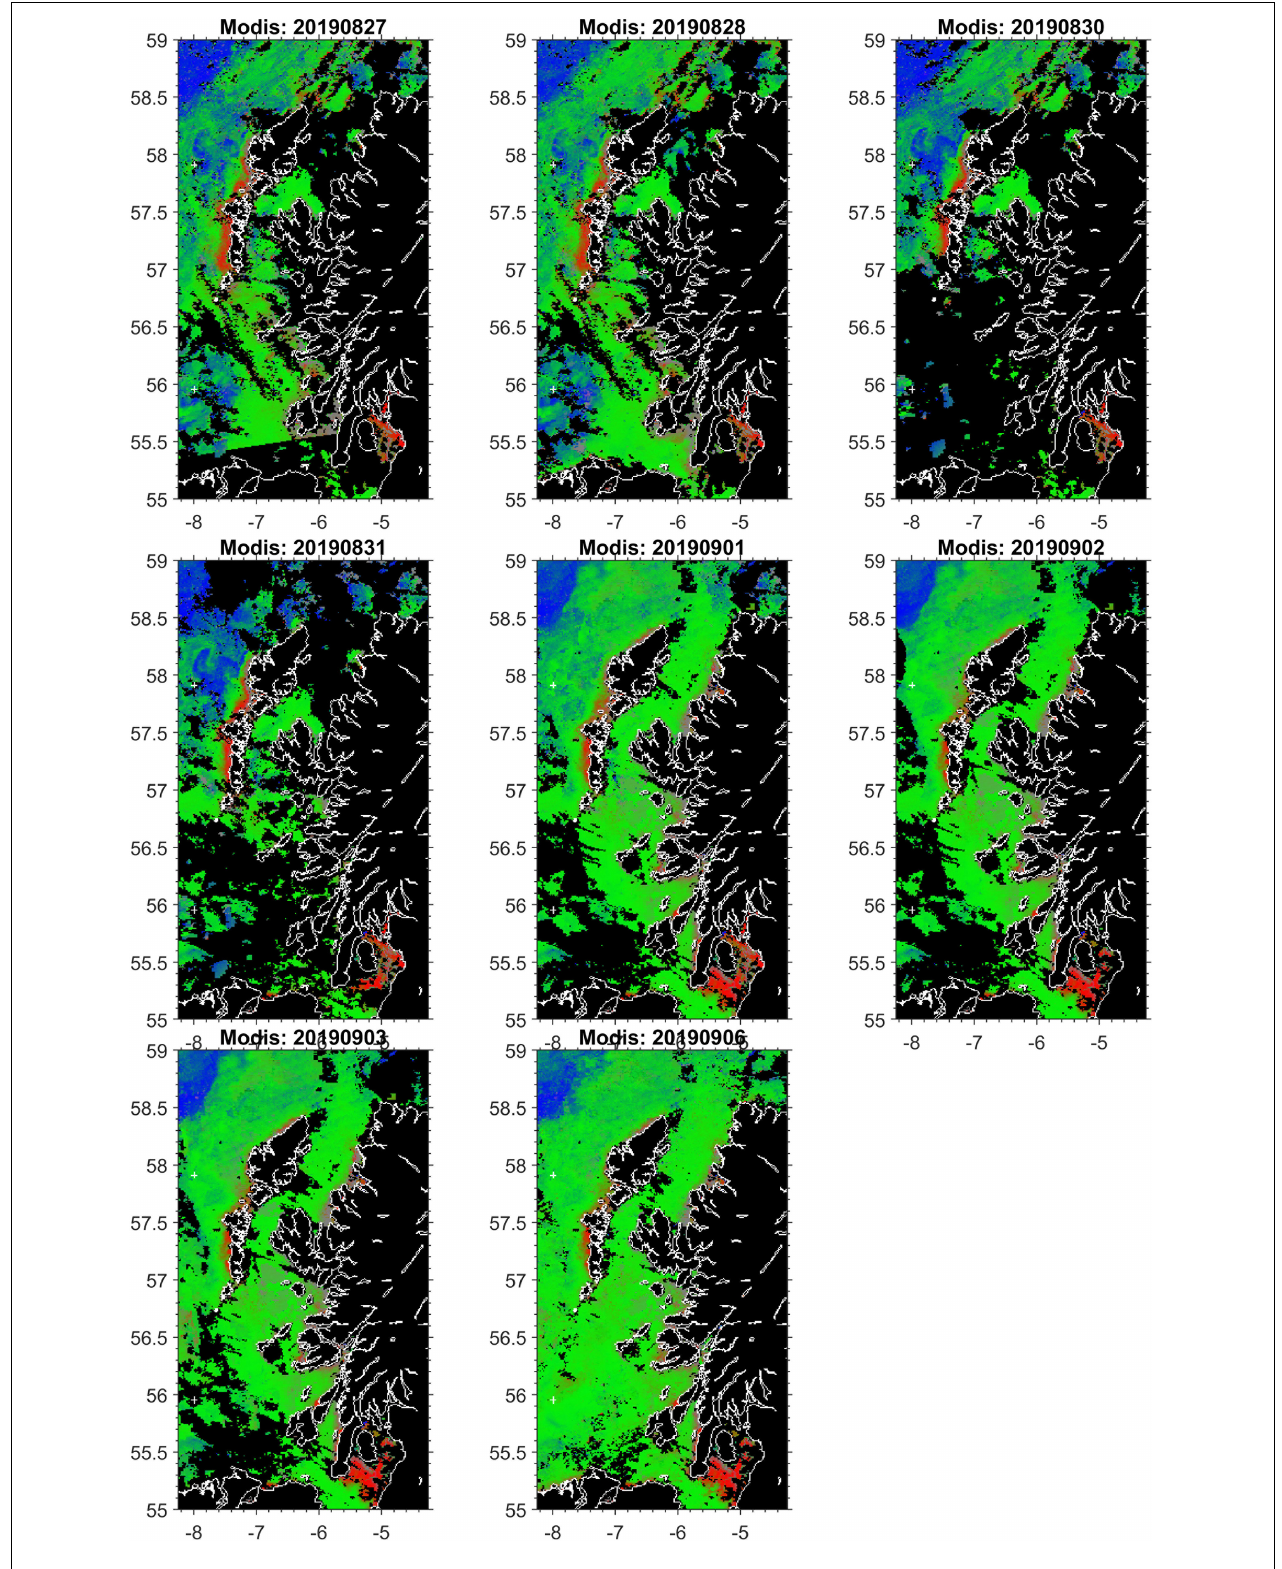
FIGURE 8 | An exemplar remote sensing based HAB risk map: elevated HABs-risk for Karenia mikimotoi was detected in Modis-satellite sea-surface colour analysis charts over 2 weeks (35 and 36) in August–September 2019 along the western coast of Hebrides and the ‘false alarm’ in the Sea of Clyde.